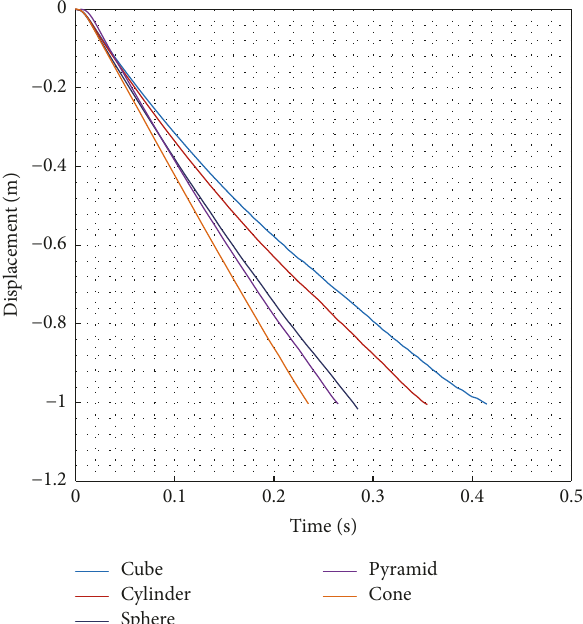
Figure 9: Displacement-time graph of pounders with different geometric